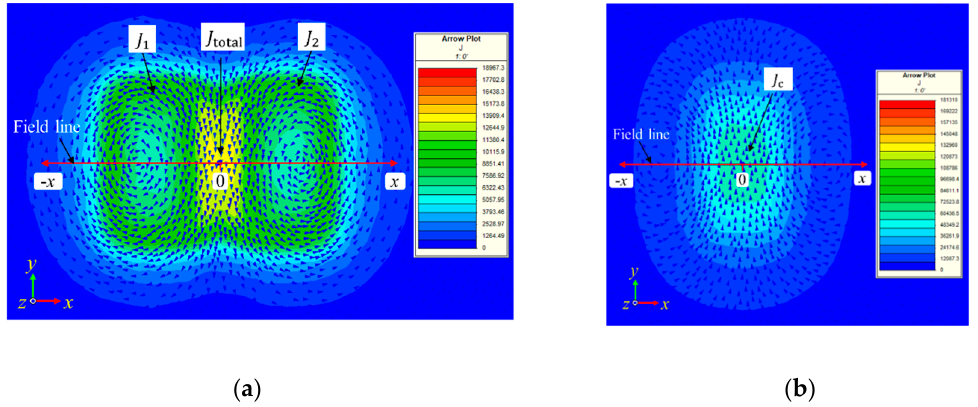
Figure 5. Arrow plot of eddy current distribution on the surface of aluminium test piece using ( a ) butterfly probe; ( b ) conventional UEC probe.